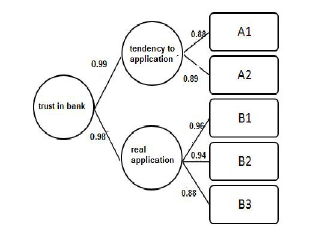
Fig. 10. The results of testing the 8 th -9 th hypotheses Fig. 11. The results of testing the 10 th -11 th